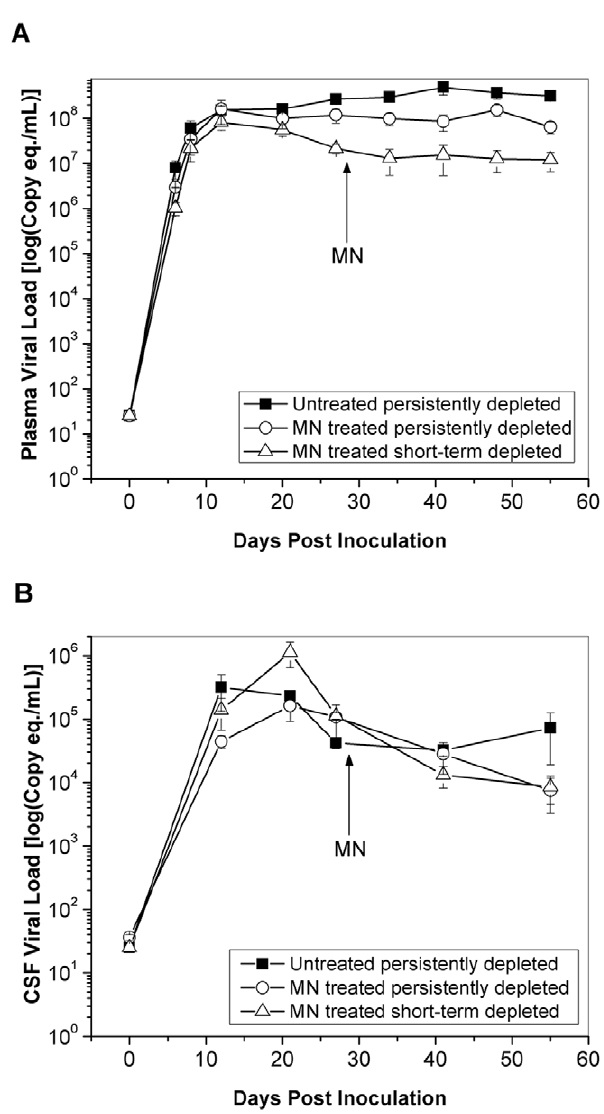
CD8-depleted animals (open circles) and MN-treated short-term CD8- depleted animals (open triangles) in plasma (A) and CSF (B) over the time course of SIV infection until 8 weeks post inoculation. Error bars represent standard error of the mean. The arrows represent the time point when minocycline (MN) treatment was initiated.